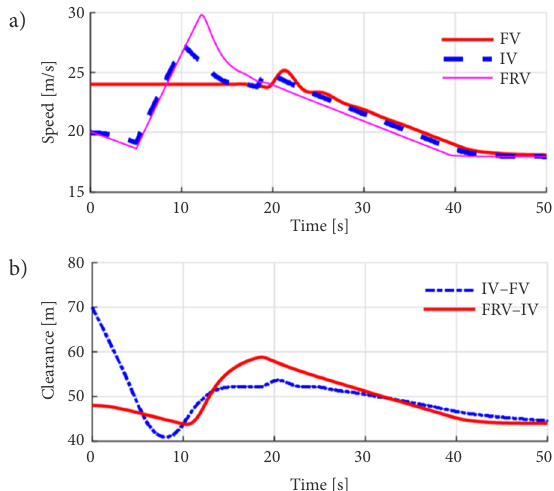
Figure 10. Speeds and clearances of vehicles considering rear-end collision escape with a high friction coefficient (source: created by the authors): a – speeds of vehicles; b – clearances between vehicles; FV – following vehicle; IV – intelligent vehicle; FRV – frontal